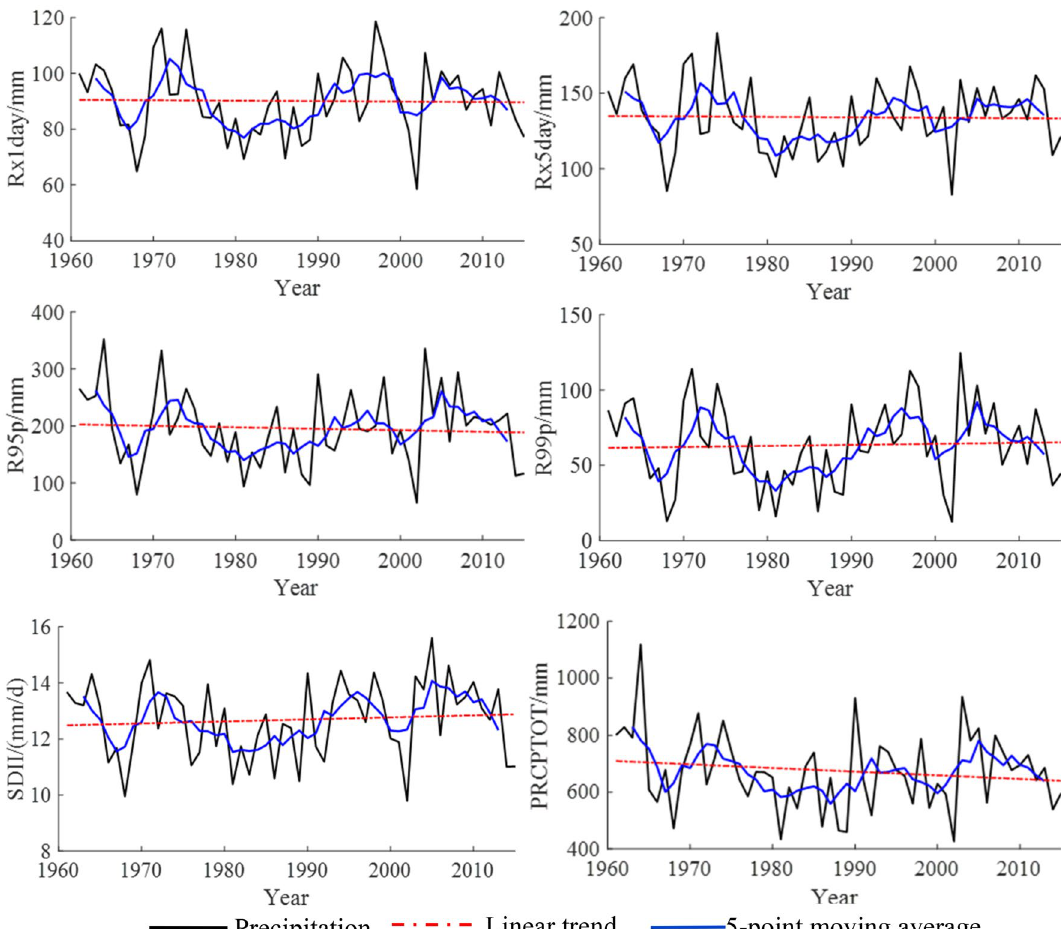
Figure 2. Temporal variations of indices related to the number of precipitation days in Shandong from 1961 to